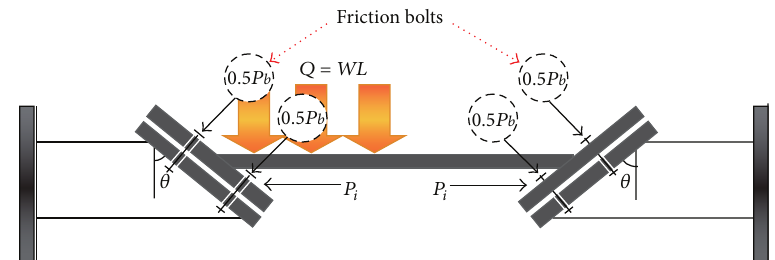
Figure 10: Simplification model of beam movement with nonsymmetric gravity load due to increase in temperature (friction bolted support).